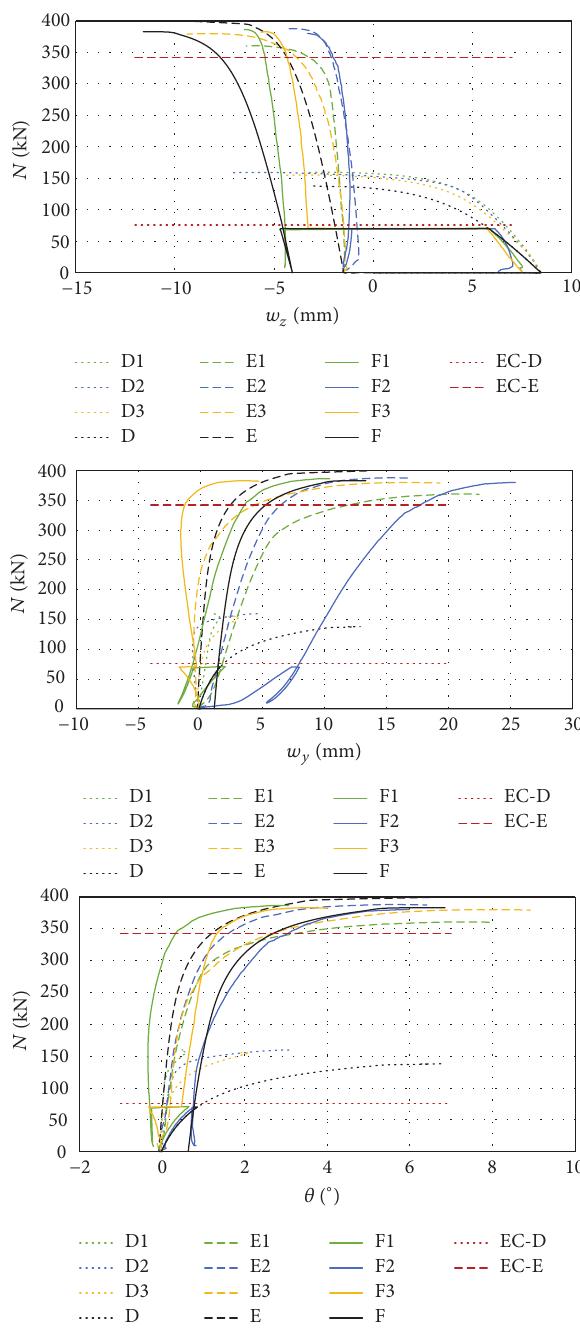
Figure 8: Graphs of deflections in the middle of the column in the direction of principal axes 𝑦 and 𝑧 and rotation 𝜃 , deflections caused by welding are included; numerical results are in black; calculation according to EC 3 is in